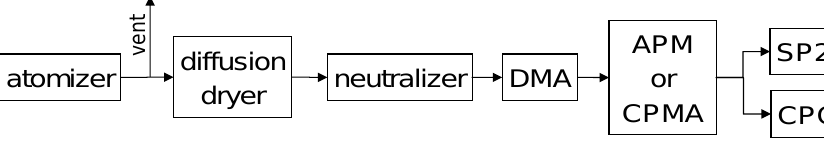
Fig. 1. Experimental setup for effective density measurements.